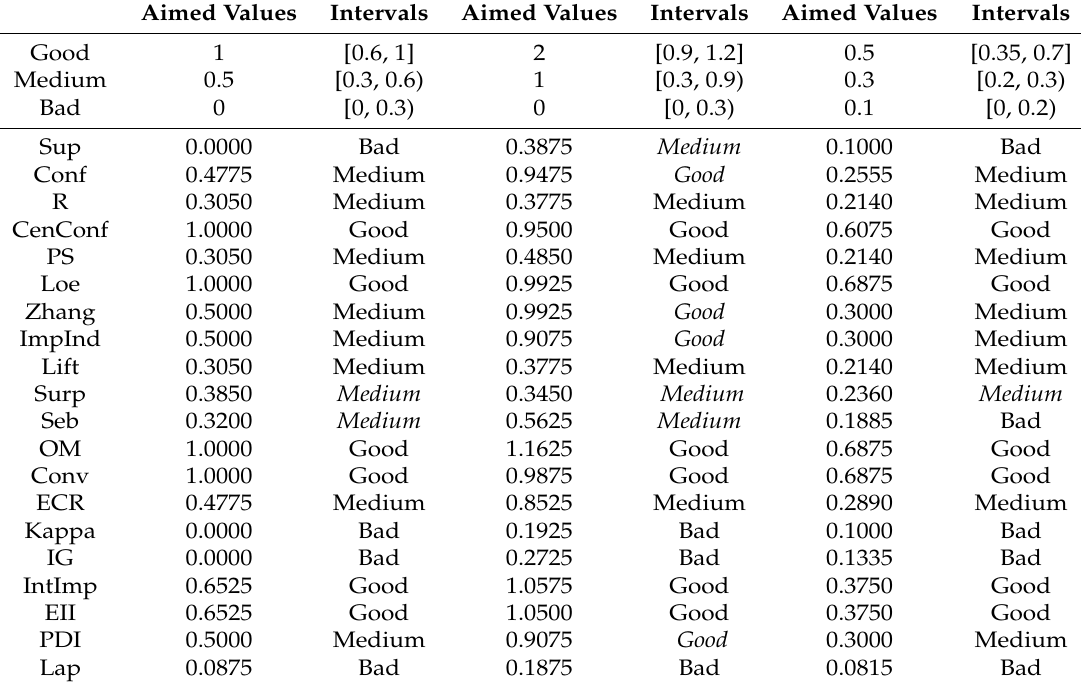
Table 8. The prediction results with different target